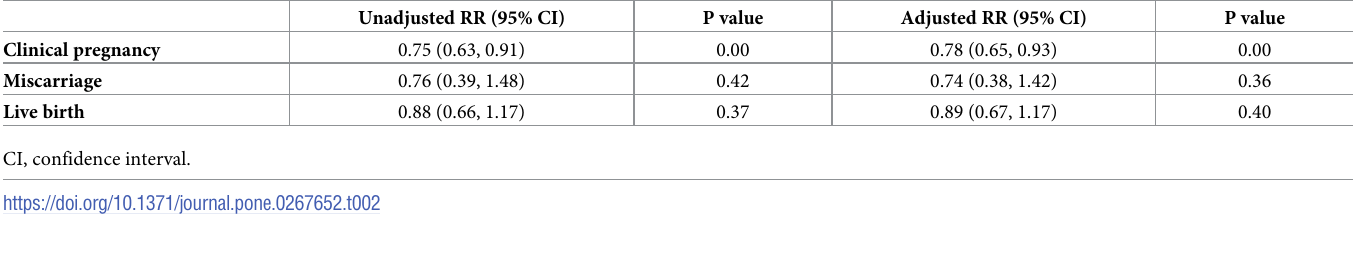
Table 2. Relative risk (RR) of each pregnancy outcome in freeze all-first (freeze all first and biopsy) versus biopsy-first (biopsy first and freeze normal).